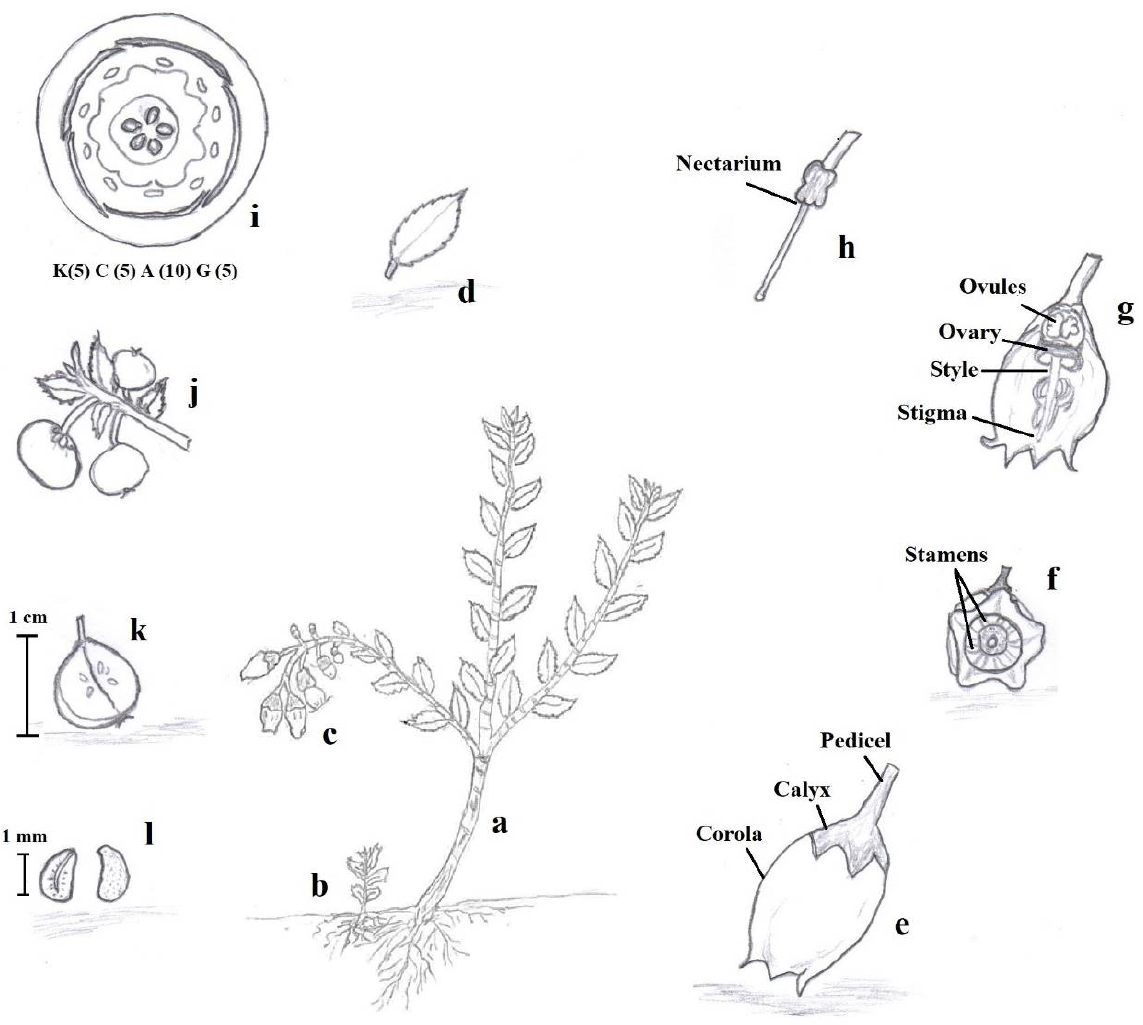
Figure 2. Description of Vaccinium floribundum Kunth: Semi-woody stem that can measure up to 2.5 m in height ( a ), Roots with their root hairs that, when they come to the surface, give rise to a seedling ( b ), White to lilac flowers in racemes of 6 to 10 ( c ), Elliptical, oval, or oval–lanceolate leathery leaves, with crenate-serrated edge, cuneate or round base, and slightly rounded acuminate apex ( d ), Corolla and Calyx ( e ), Vertical view of stamens ( f ), Gynoecium ( g ), Nectaries ( h ), Floral diagram of the Ericaceae ( i ), Round bittersweet berries of bluish to black color ( j ), Fruit in longitudinal section ( k ), Recalcitrant seeds of approximately 1 mm in size ( l ). Source: Herbarium of the Interpretation Center of the Protective Forest “La Prosperina” (BPP—Ar001E), of the Escuela Superior Polit é cnica del Litoral (ESPOL), Guayaquil—Ecuador, by Botanist Jaime Naranjo